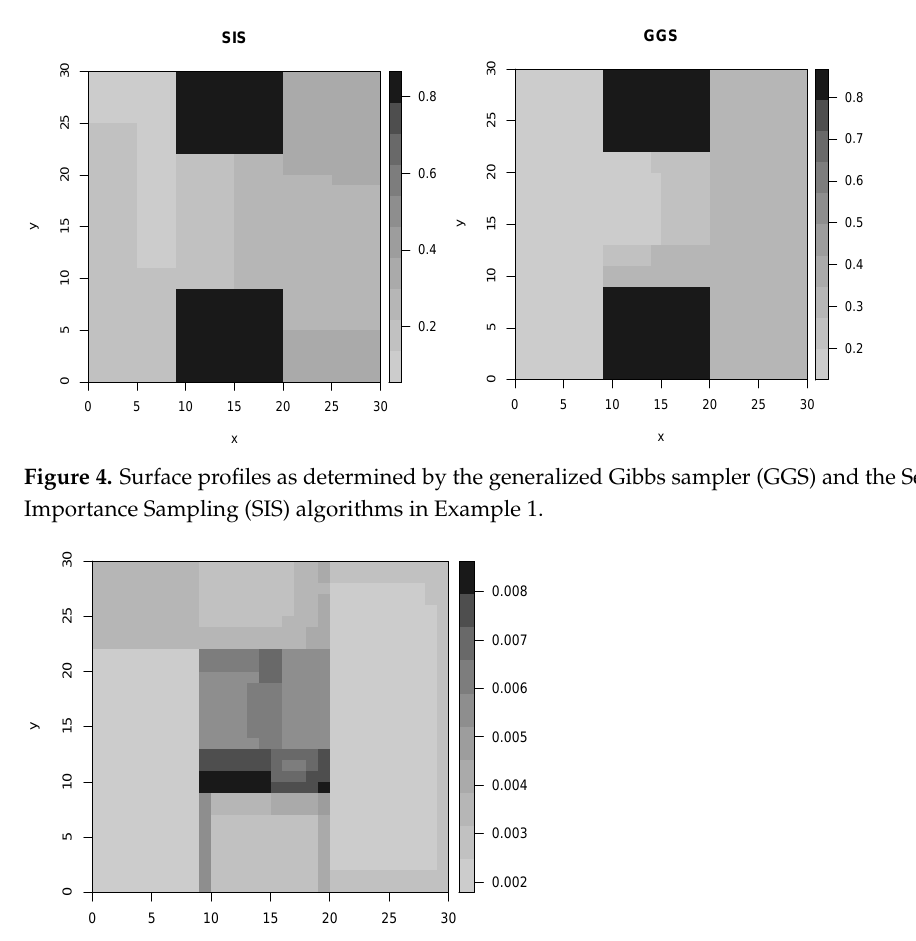
Figure 3. Autocorrelation curve (Example 1).